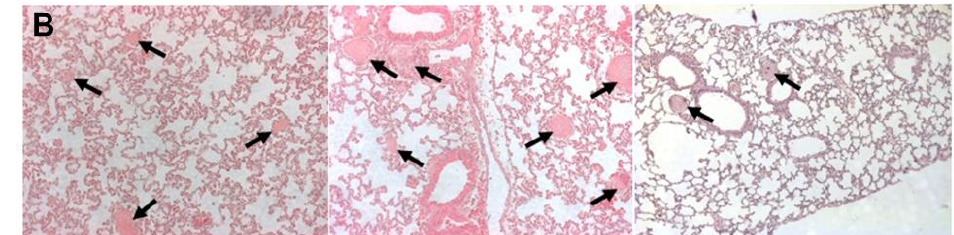
Figure 2. Effects of tTF-NGR on normal (non-athymic) CD-1 or BALB/C mice. ( A ) Lethality given as percentage of mice treated (1 day observation period) for normal (non-athymic) CD-1 or BALB/C mice (2–5 months old) upon i.v. injection of tTF-NGR at the doses of 0.0, 1.5, 3.0, 5.0, 6.0, 8.0, and 10.0 mg tTF-NGR/kg body weight. LD10 (lethal dose for 10 % of the animals treated) was 5.0 mg/kg or 15.0 mg tTF-NGR/m 2 b.s.a. ( B ) H & E staining of lungs of mice that died upon treatment with toxic doses of tTF-NGR. Blood vessels are thrombosed (arrows).